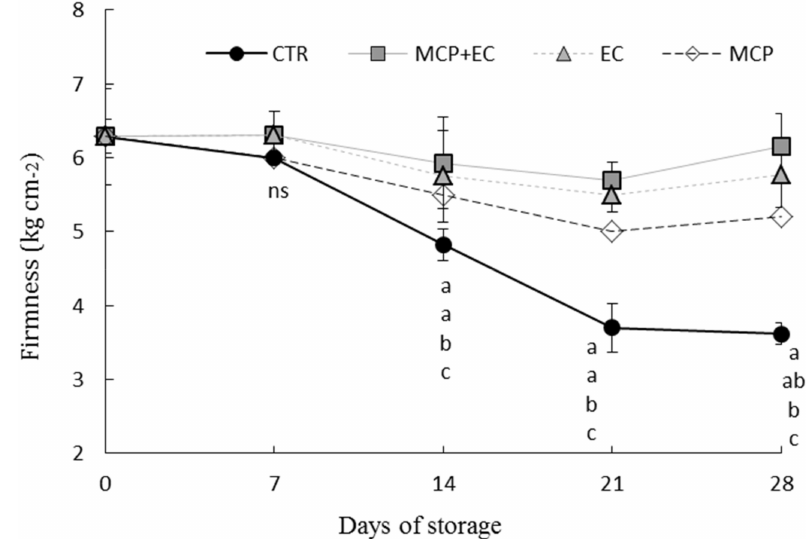
Figure 2. Evolution of fruit firmness (Kg cm − 2 ) in white flesh melting peaches ( P. persica ) cv Settembrina treated with the edible coating (EC) and 1-MCP + EC, 1-MCP (MCP) and untreated (CTR) stored at 1 ◦ C for 7, 14, 21 28 days. Data correspond to the means ± standard error (SE) of 15 replicates. Means with di ff erent letters are significantly di ff erent at p ≤ 0.05 using Tukey’s test. ns = not significant. Di ff erent lowercase letters denote significant di ff erences ( p ≤ 0.05) among di ff erent treatments for the same sampling